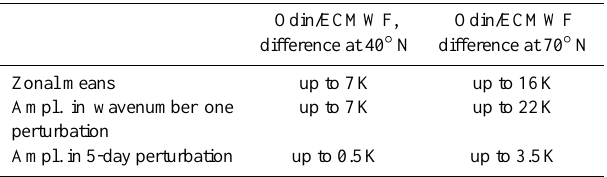
Table 1. Discrepancies in the temperature data by Odin and ECMWF.